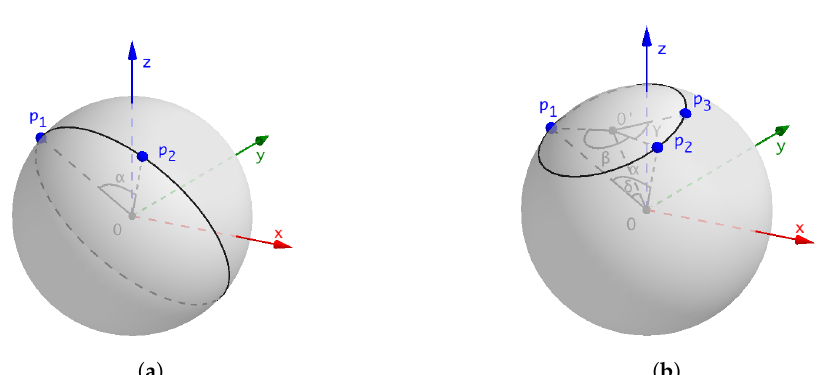
Figure 6. Analysis of 2- and 3-point sequence insertion. ( a ) 2-point sequence insertion; ( b ) 3-point sequence